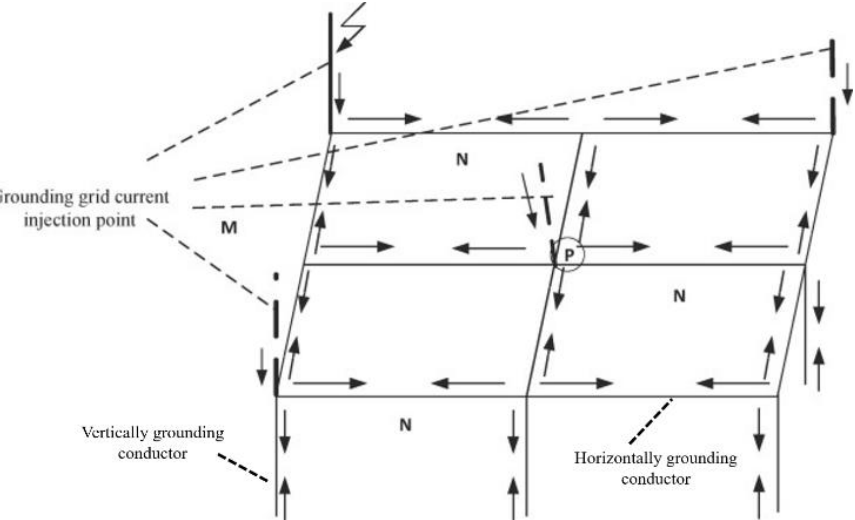
Figure 2. Network grounding system model